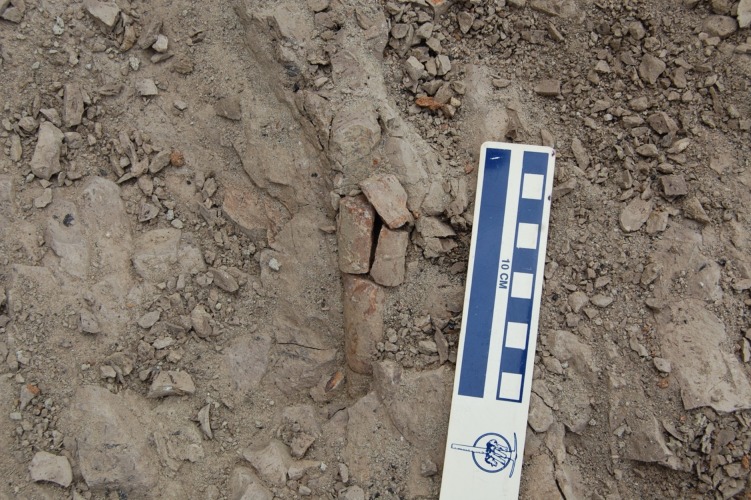
Exposed end of Centrosaurus rib upon initial discovery.